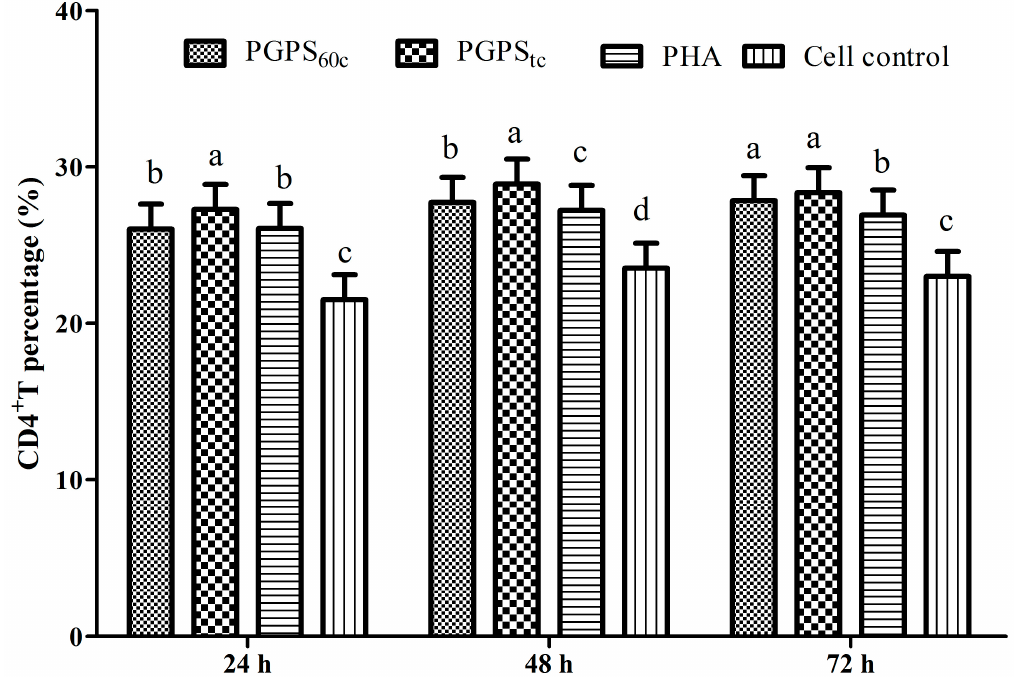
Figure 4. Changes of peripheral blood CD4 + T cells in stimulation of PGPSs or PHA. The values are presented as means ± SE ( n = 4). a–d Bars without the same superscripts differ significantly ( p <